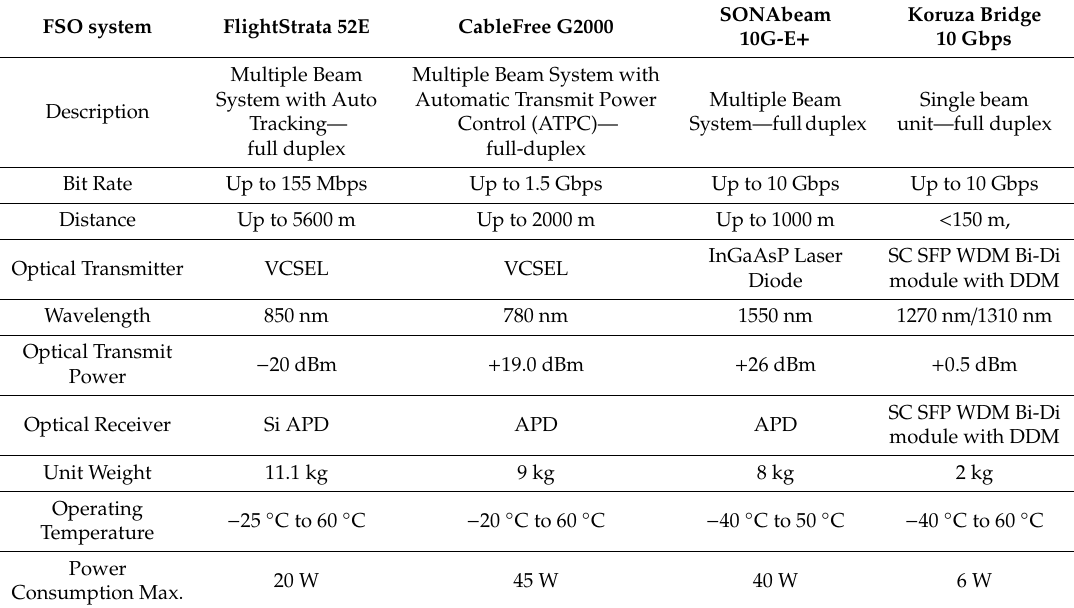
Table 1. Summary of the basic commercial FSO system parameters